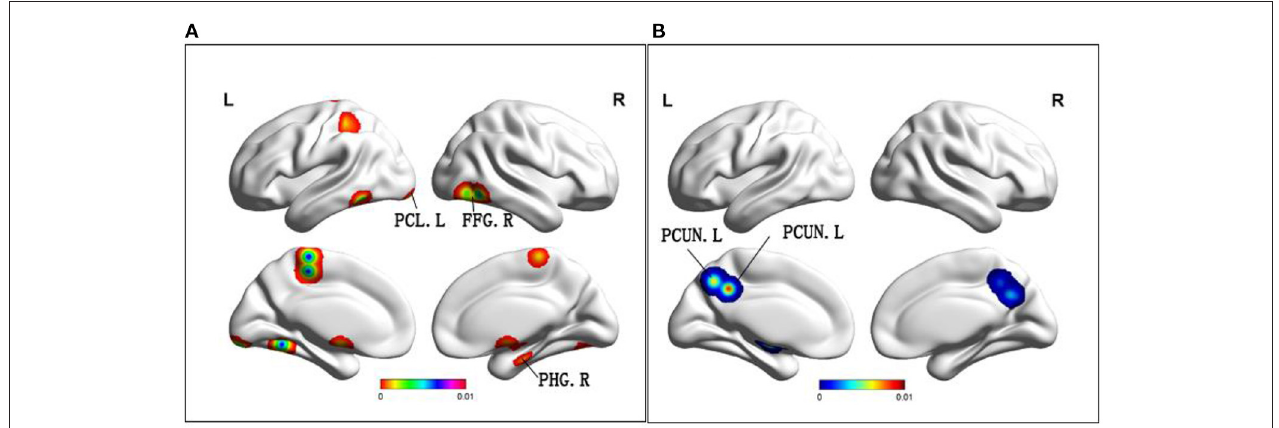
FIGURE 2 | (A) Brain regions showing increased ALFF in MCI patients compared to HCs. (B) Brain regions showing decreased ALFF in MCI patients compared to HCs. MCI, amnestic mild cognitive impairment; HCs, healthy controls; ALFF, the amplitude of low frequency fluctuation; PCL, paracentral lobule; FFG, fusiform gyrus;